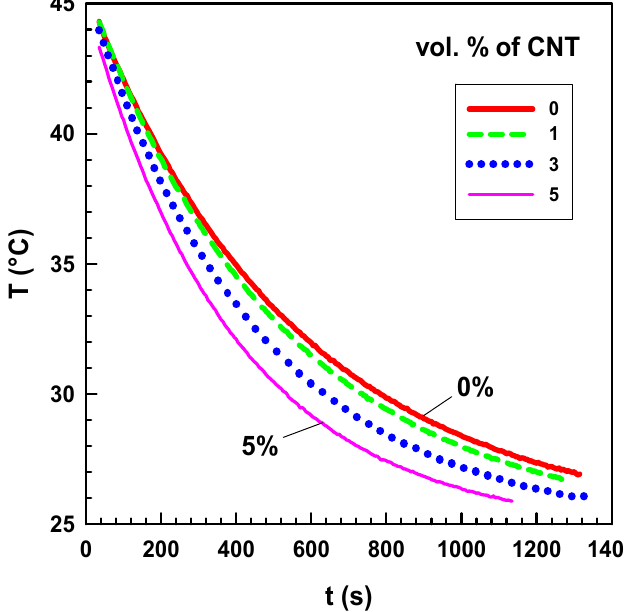
Figure 12. Temperature as a function of time for CNT/silicone composites with various CNT